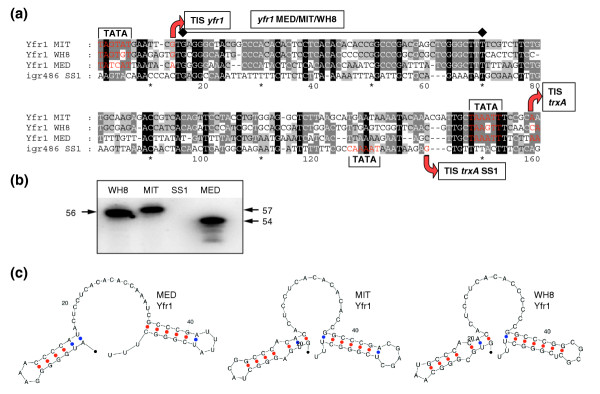
Experimental screen for the presence of an RNA-coding gene in the guaB-trxA  intergenic region. (a) Sequence alignment of the guaB-trxA (guaB: sequence not shown, located upstream of yfr1) intergenic region visualises the conserved yfr1 gene labeled by the bar above the alignment and its transcriptional initiation site in three of the analyzed strains (MED, MED4; MIT, Prochlorococcus strain MIT 9313; WH8, Synechococcus sp. WH 8102) but not in Prochlorococcus strain SS120 (SS1). Transcriptional initiation sites (TIS) and the deduced -10 elements are indicated. (b) Northern blots show a signal for Yfr1 at a size of 54, 56 and 57 nucleotides (nt) for MED4, WH 8102 and MIT 9313, respectively. No signal with RNA from SS120 confirms the absence of this gene in this strain, as was predicted from the sequence data. (c) Predicted secondary structures of Yfr1 in MED4, MIT 9313 and WH 8102 by MFOLD [59].